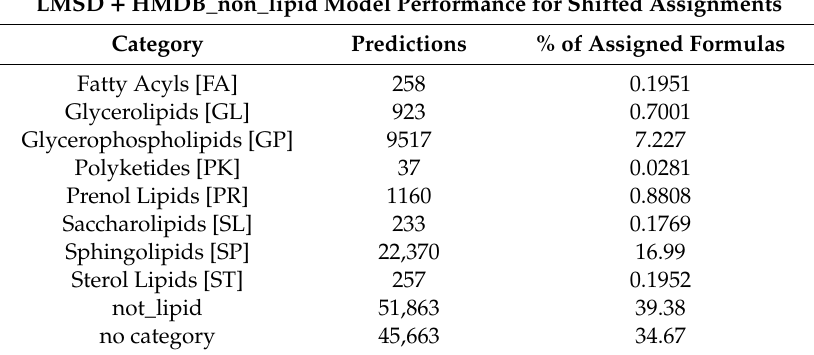
Table 6. LMSD + HMDB_non_lipid model performance for shifted